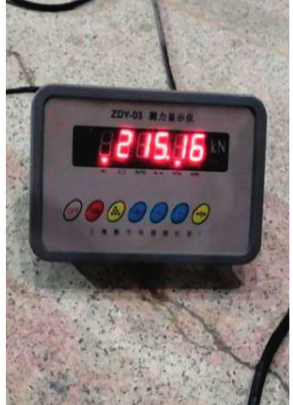
Figure 12: Force measuring